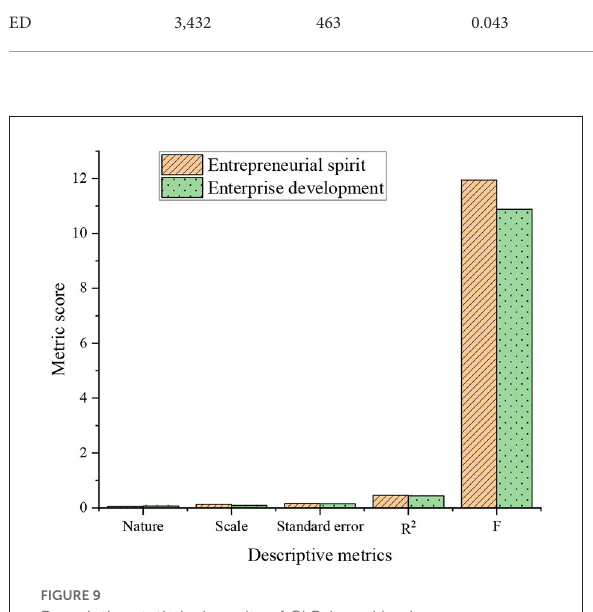
FIGURE9 Descriptive statistical results of CLR-based business environment optimization, ES, and ED.